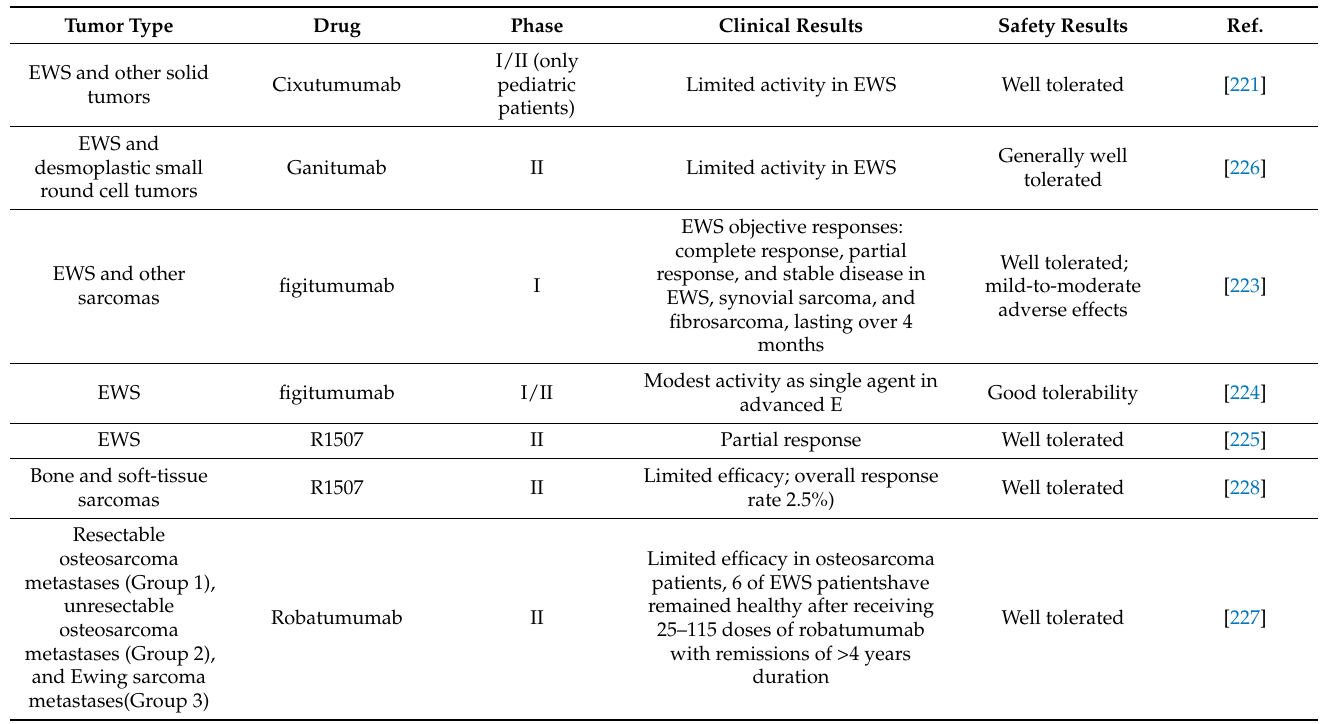
Table 3. Anti-IGF-IR mAb targeting the IGF axis in sarcomas and their clinical phase of development. Tumor Type Drug Phase Clinical Results Safety Results